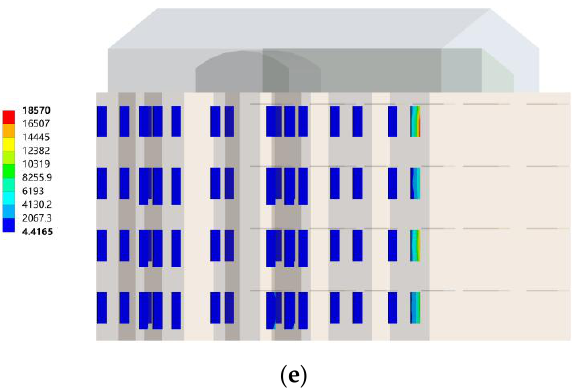
Figure 13. Southeast wind, northward vertical sun visor changes with the orientation of the building. ( a ) Cloud map of sun visors in the south direction; ( b ) Sun visor cloud map in the direction of south by west 15; ( c ) Cloud map of sun visors in the direction of south by west 30; ( d ) Cloud map of the sun visor in the direction of south by east 15; ( e ) Cloud map of sun visors in the direction of south by east 30.